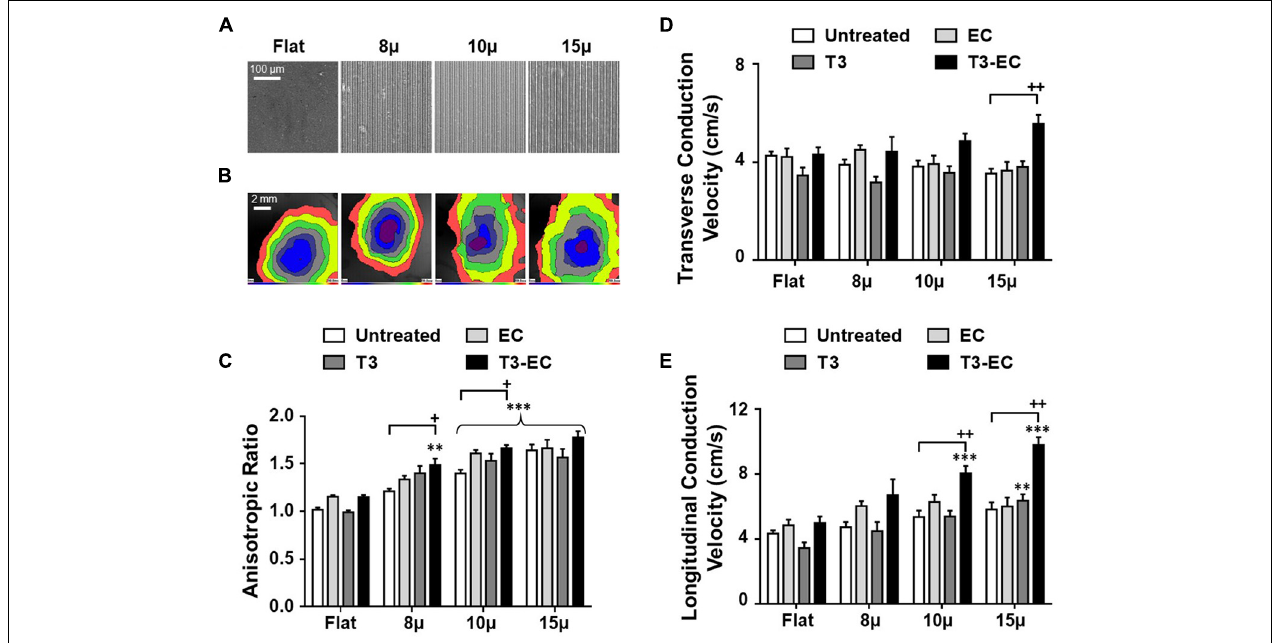
FIGURE 1 | Microgroove-induced alignment ( µ ), triiodothyronine (T3), and electrical conditioning (EC) promote conduction anisotropy synergistically by increasing longitudinal conduction velocity (LCV). (A) Microscopic view of flat and microgrooved substrates with defined dimensions. (B) Isochronal map showing the induced anisotropy in AP conduction in microgrooved hvCAS when compared to that of flat control. (C) Anisotropic ratio (AR), (D) transverse conduction velocity (TCV), and (E) longitudinal conduction velocity (LCV) of hvCAS with different substrates and different treatment conditions. Data was generated by seven batches of independent differentiations; n = 5–9 for each group. (C–E) Two-way ANOVA test followed by Turkey multiple comparison test. ∗ compared to flat control with the same treatment; +, compared to untreated condition of the same substrate. + indicates p < 0.05, ∗∗ or ++ indicate p < 0.01, and ∗∗∗ indicates p < 0.001.